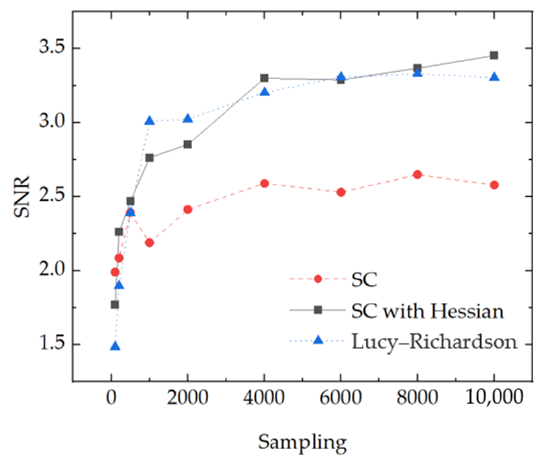
Figure 6. The signal-to-noise ratio (SNR) of an image reconstructed by the SC, SC filtered by Lucy– Richardson and SC with a Hessian filter.